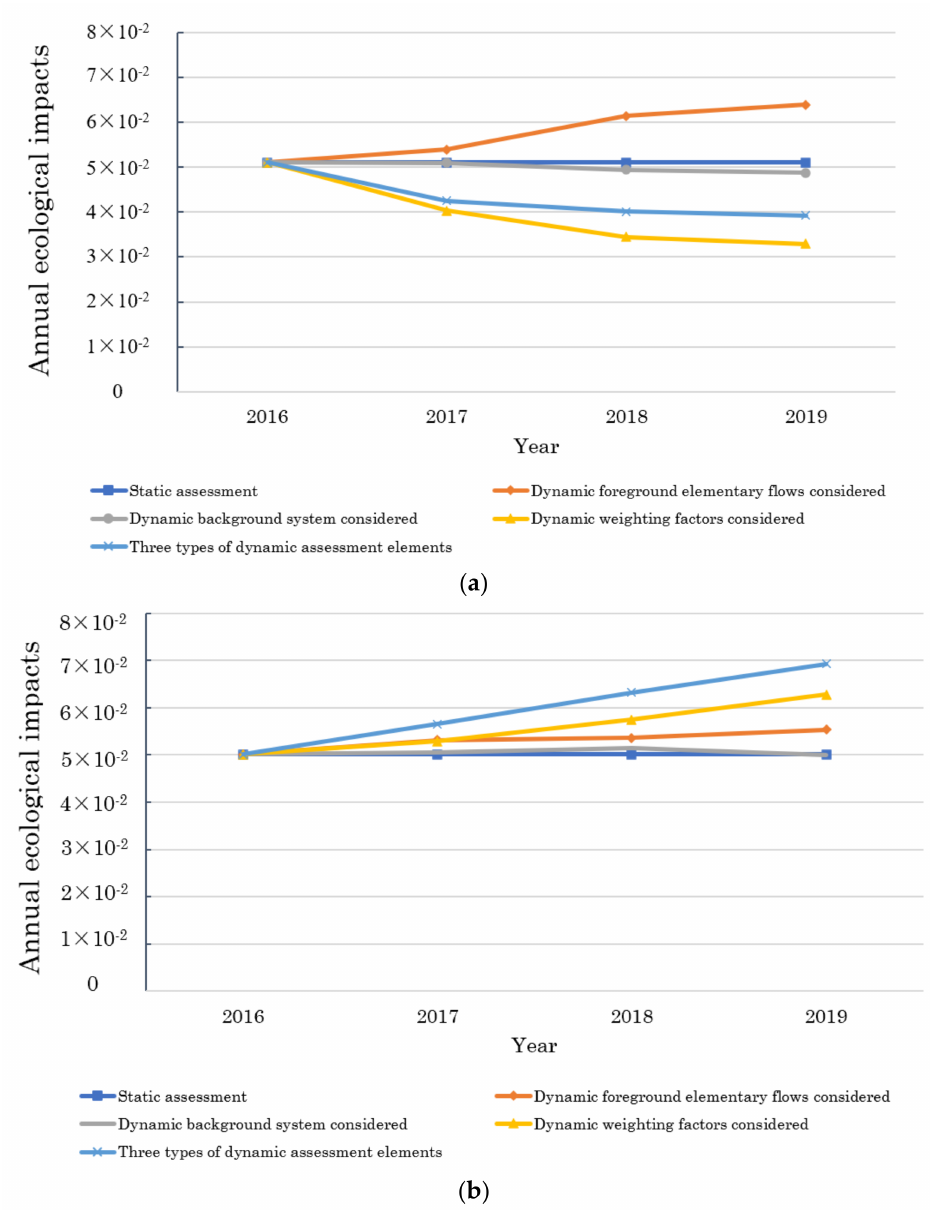
Figure 7. The annual ecological impacts (per m 2 ) in ( a ) Nanjing and ( b ) Guangzhou with different types of dynamic assessment elements